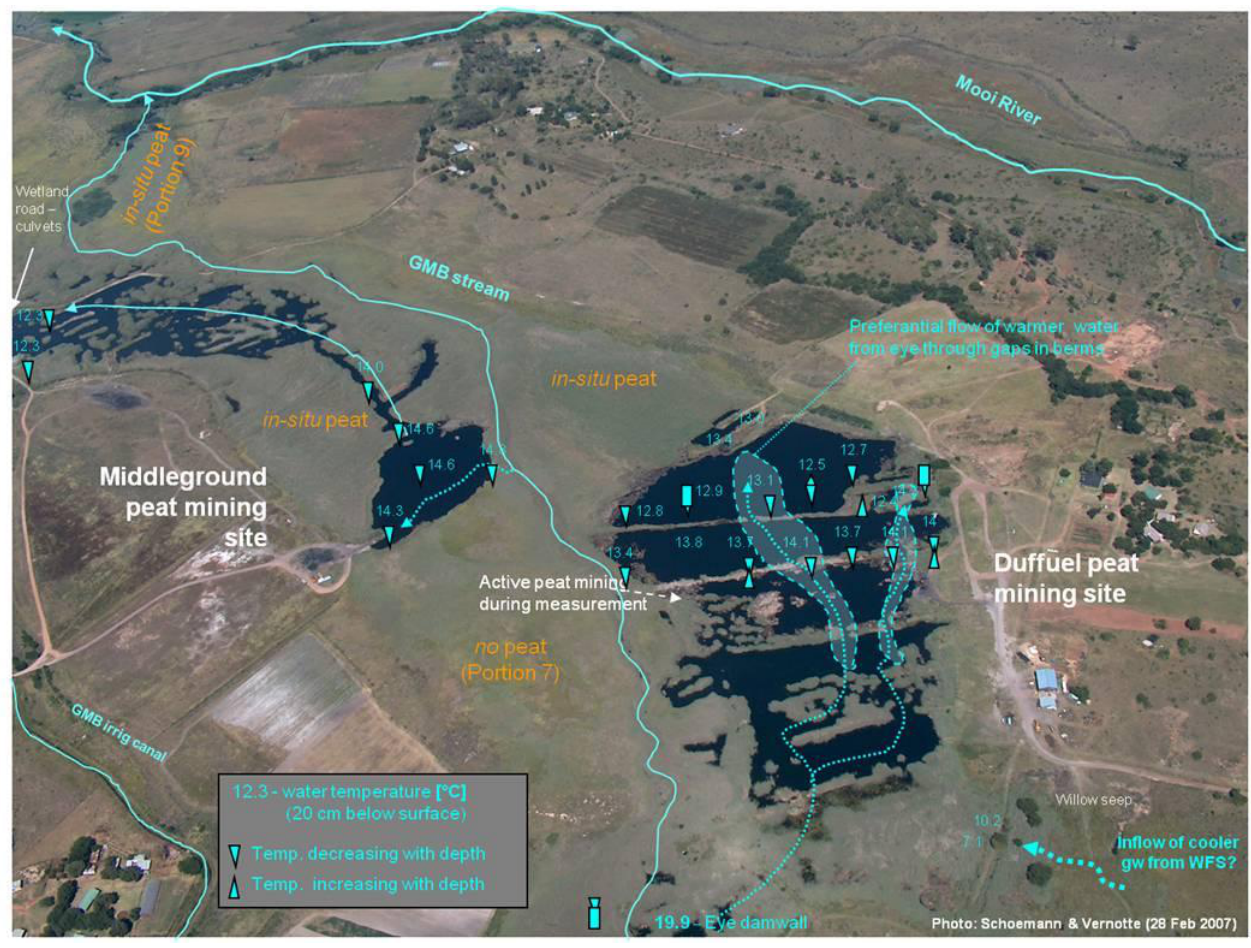
Figure 4. Horizontal and vertical distribution of water temperature as measured during a survey of the Gerhard Minnebron wetland aimed at detecting the possible influx of (warmer) groundwater into the wetland (measured on 8 June